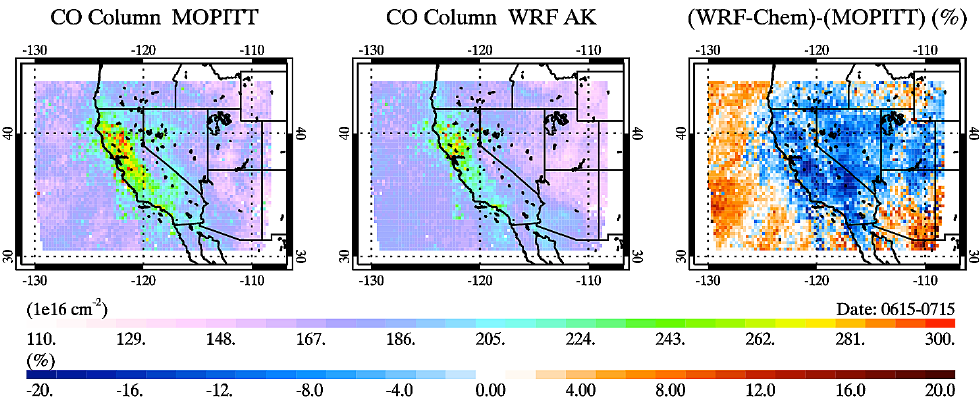
Fig. 3. CO Column retrieved from MOPITT for 15 June–15 July 2008 and corresponding WRF-Chem simulations with MOPITT operator applied. The difference plot shows the percentage difference between WRF-Chem and MOPITT.